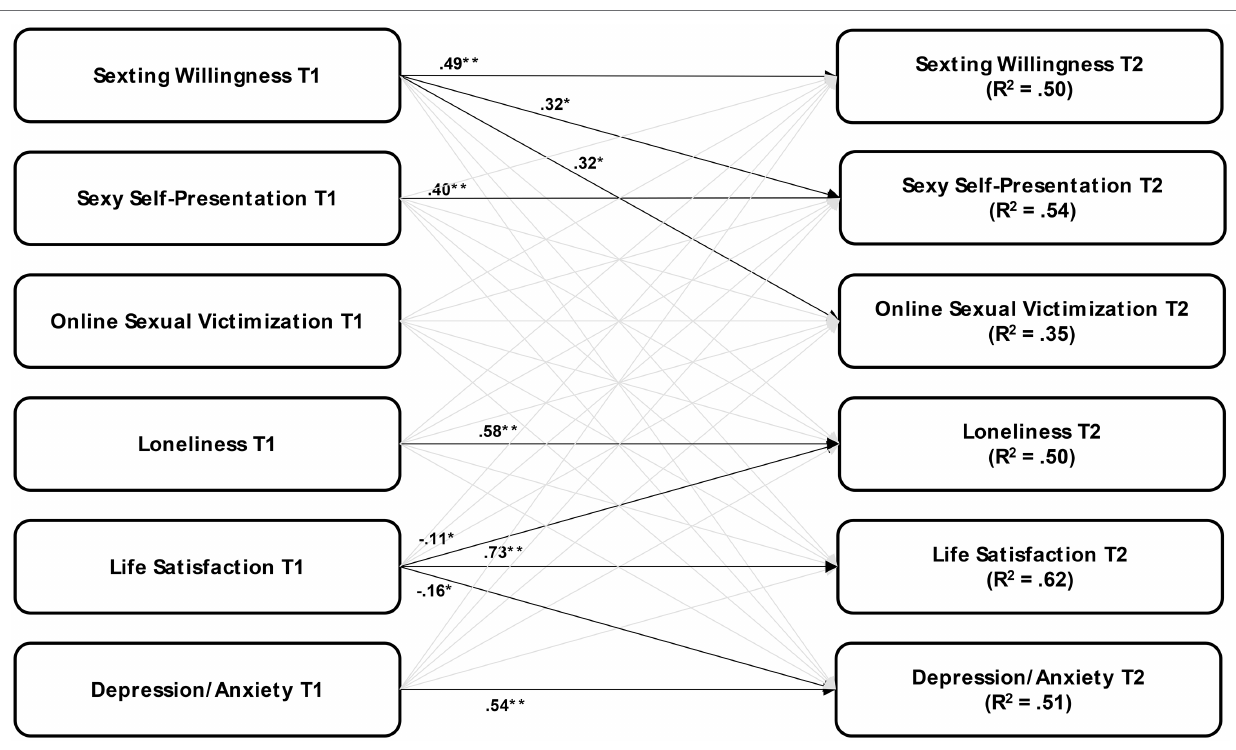
FIGURE 1 | Cross-lagged panel model to explain the longitudinal relationships between online sexual engagement (OSE), online sexual victimization (OSV), and psychosocial well-being. χ 2(df) = 2,062(1,070), p < 0.001, CFI = 0.951, TLI = 0.943, RMSEA = 0.047, and SRMR = 0.038. Indicated are the significant standardized path coefficients ( β ). ** p < 0.01 and * p < 0.05. Non-significant paths are greyed out. Co-variances were calculated, but omitted for better overview. The model was additionally controlled for a person’s age, gender, sexual orientation, and amount of online